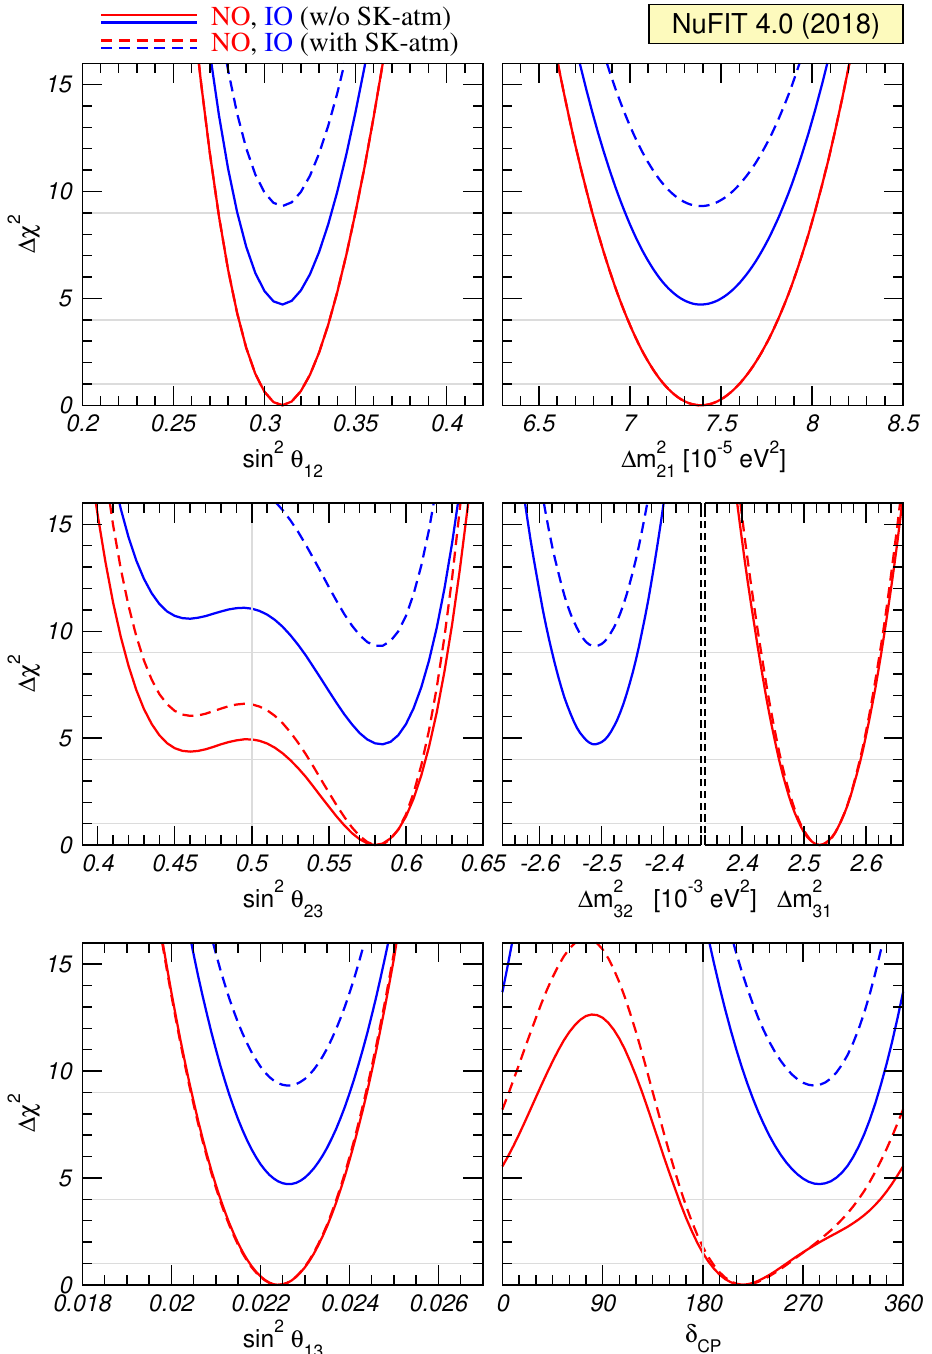
Figure 1 . Global 3 (cid:23) oscillation analysis. We show (cid:1) (cid:31) 2 pro(cid:12)les minimized with respect to all undisplayed parameters. The red (blue) curves correspond to Normal (Inverted) Ordering. Solid (dashed) curves are without (with) adding the tabulated SK-atm (cid:1) (cid:31) 2 . Note that as atmospheric mass-squared splitting we use (cid:1) m 2 for NO and (cid:1) m 2 for IO. 31 32